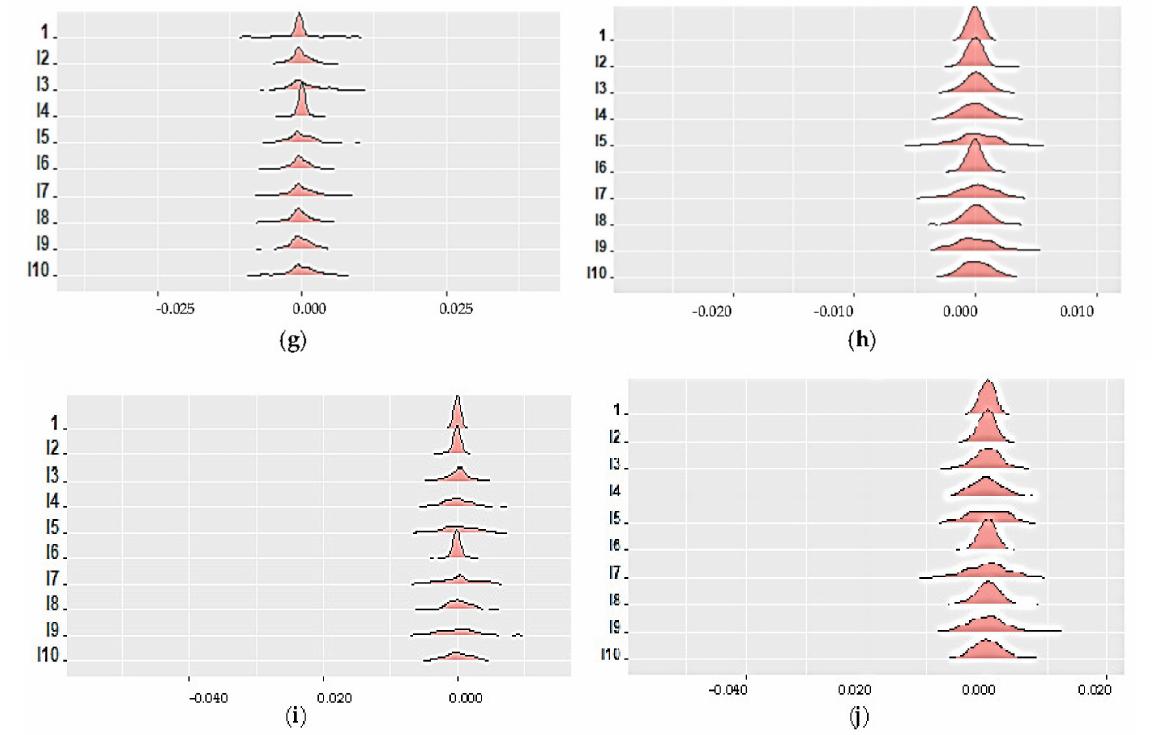
Figure 2. The 5-min spot returns in the first ten days of the sample period in the form of a histogram. ( a ) CAD spot-histogram, ( b ) CAD futures-histogram, ( c ) CNY spot-histogram, ( d ) CNY futures-histogram, ( e ) EUR spot-histogram, ( f ) EUR futures- histogram, ( g ) GBP spot-histogram, ( h ) GBP futures-histogram, ( i ) JPY spot-histogram, and ( j ) JPY futures-histogram.